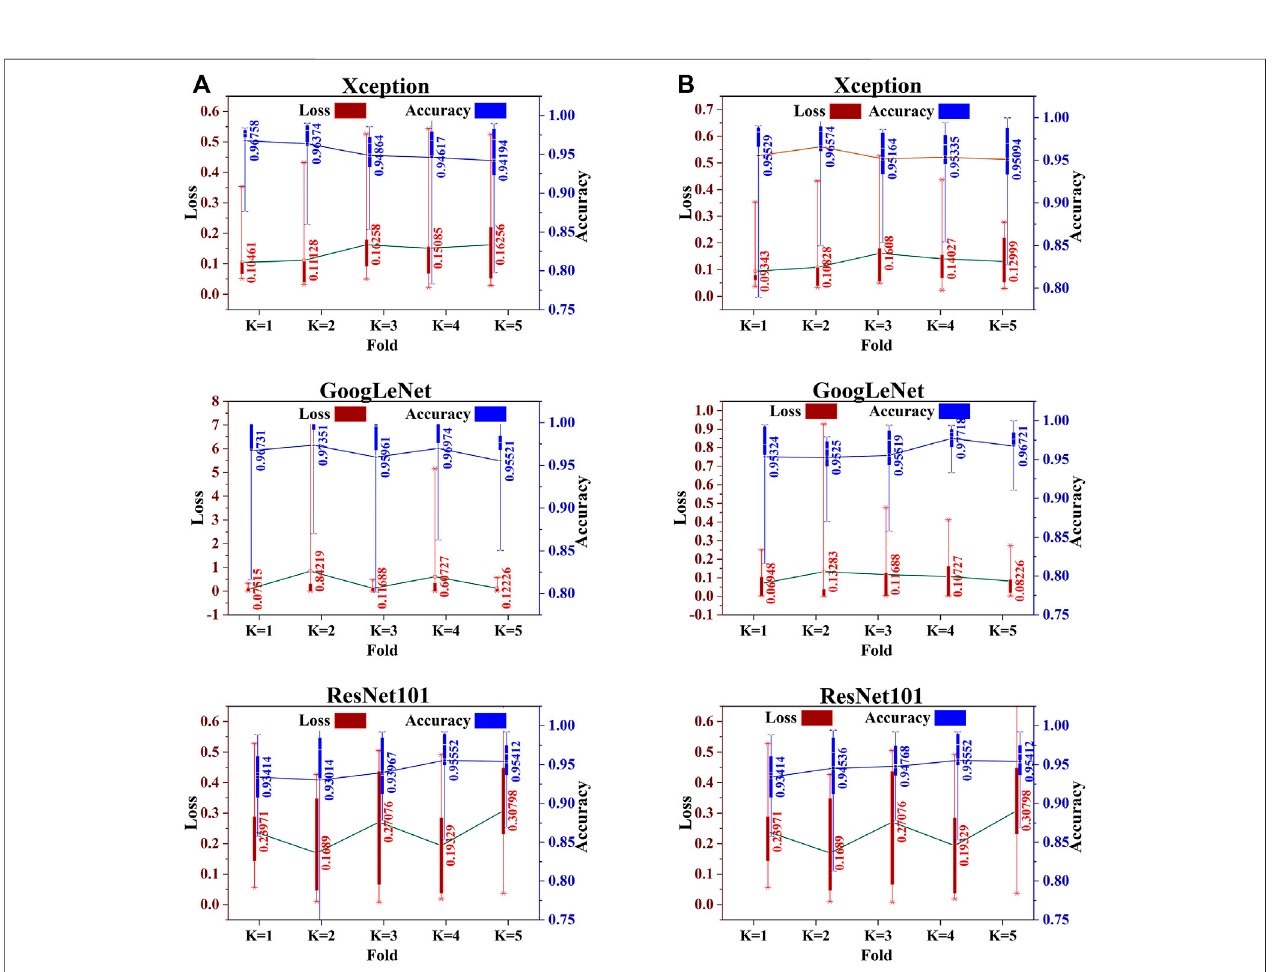
FIGURE2| Five-foldcross-validation accuracyandlossofeachindividualclassi fi erfor (A) informativeframedetectionand (B) cancerousandnoncancerous polyp categorization.